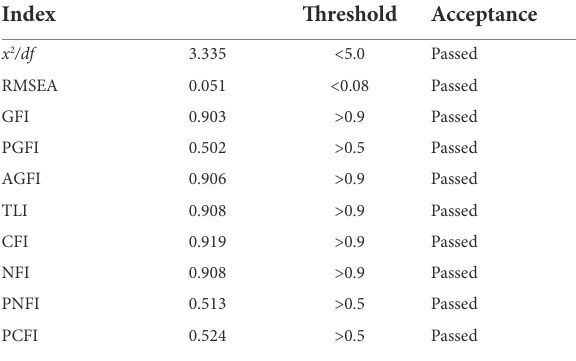
TABLE 5 Goodness-of-fit statistics for structural model.